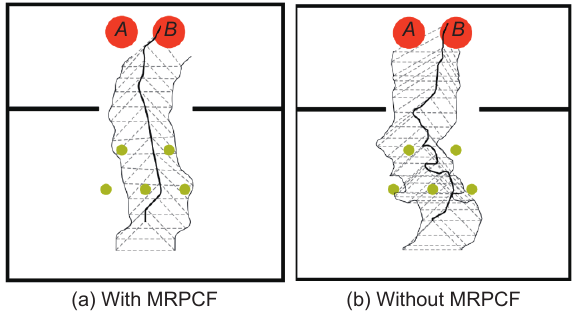
Fig. 7 Trajectories of multi-robot navigation tasks with and without MRPCF for a